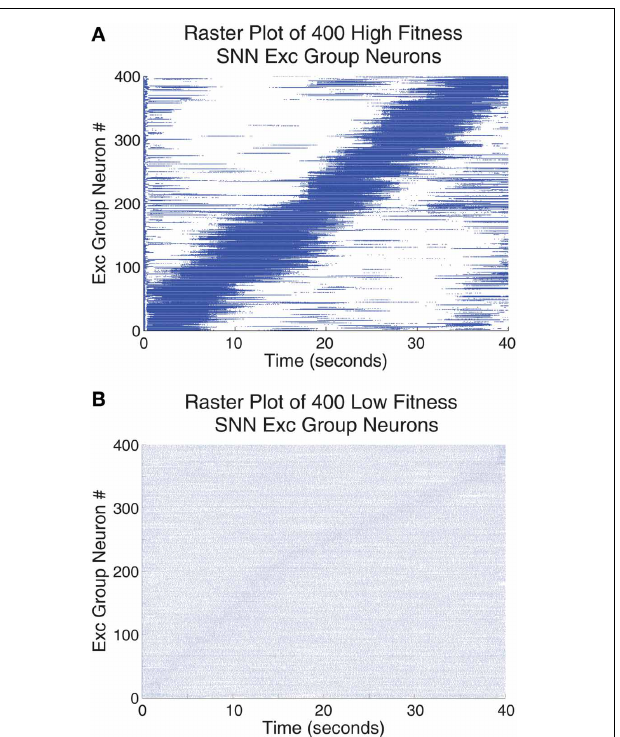
FIGURE 7 | The responses of the Exc group neurons (identified by their neuron id on the y-axis) were tested for all 40 grating orientations. One orientation was presented per second and the test ran for 40s (x-axis). (A) Neuronal spike responses of 400 neurons trained with the highest fitness SNN parameters found using the parameter tuning framework. (B) Neuronal spike responses of 400 neurons trained using a single set of low fitness parameters. The neurons were arranged such that those neurons responding to similar orientations were grouped together for both (A,B) . This accounts for the strong diagonal pattern found in (A) and the very faint diagonal pattern found in (B) . Neuronal spike responses in (A) are sparse in that relatively few neurons code for one orientation while neuronal spike responses in (B) are not sparse. Additional, many of the neuronal spike responses in part (A) employ a wide range of firing rates to describe a subset of the orientation stimulus space while spike responses in (B) have similar firing responses across all angles in all